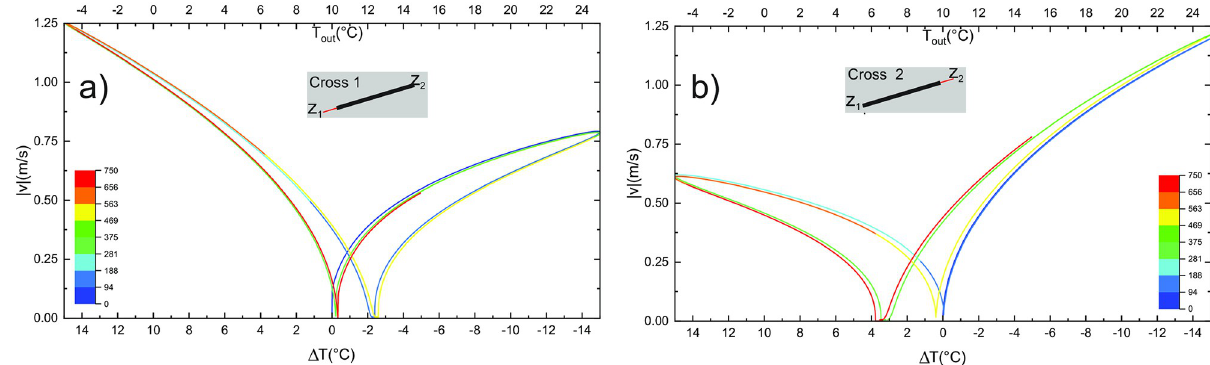
Fig 12. Airflow pattern | v ( Δ T )|for scenarios with change in cross-sections as shown in the insert. Colours indicate the progress in time as given in the bar codes.